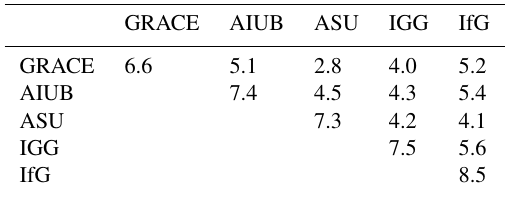
Table 5. Comparison of Swarm solutions from different institutes. Orbit product, computing method, and maximum d/o are provided. AIUB ASU IGG IfG Orbit AIUB (screened version) ITSG ESA IfG Approach Celestial mechanics approach Acceleration approach Short-arc approach Short-arc approach max d/o 70 40 40 60